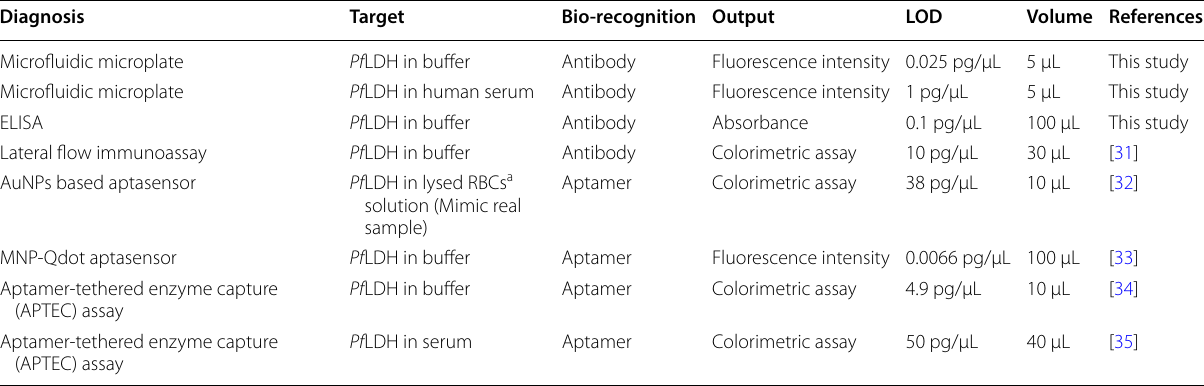
a RBC red blood